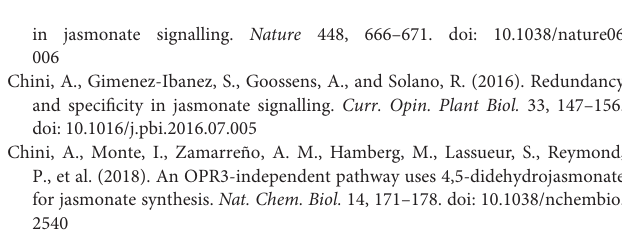
Supplementary Figure 1 | 1 H NMR spectrum of iso -OPDA. Supplementary Figure 2 | 13 C NMR spectrum of iso -OPDA. Supplementary Figure 3 | Sequence alignment of COIs. Supplementary Figure 4 | Differences between cloned CpMYC2s sequences and annotated sequences in the genome database. Supplementary Figure 5 | Sequence alignment of MYC2. Supplementary Figure 6 | Expression of GST-CpMYC2s and FLAG-JAZs. Supplementary Table 1 | Primers used in this